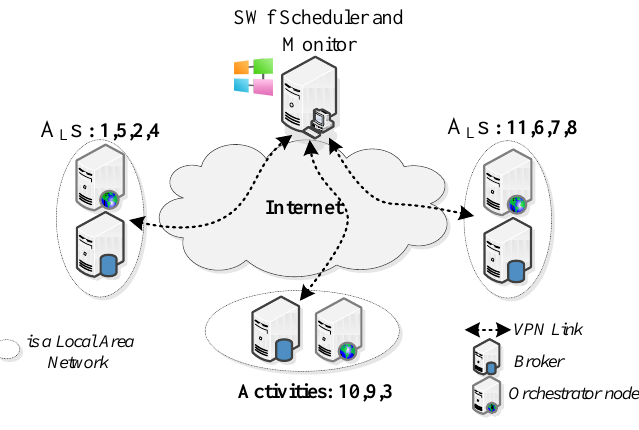
Figure 9. Network topology of the evaluation